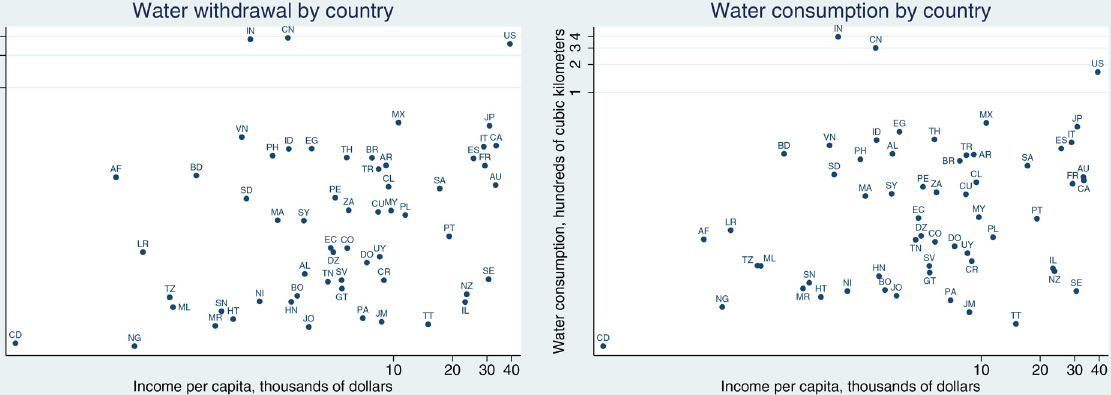
Fig 1. Water withdrawal and consumption by country. The scatter plot as appeared on the left side of the diagram illustrates the relationship between each country ’ s water withdrawal and per capita income while right side of the diagram demonstrates the relationship between each country ’ s water consumption and per capita income. On each plot, country names are labeled with the ISO-3166 codes.